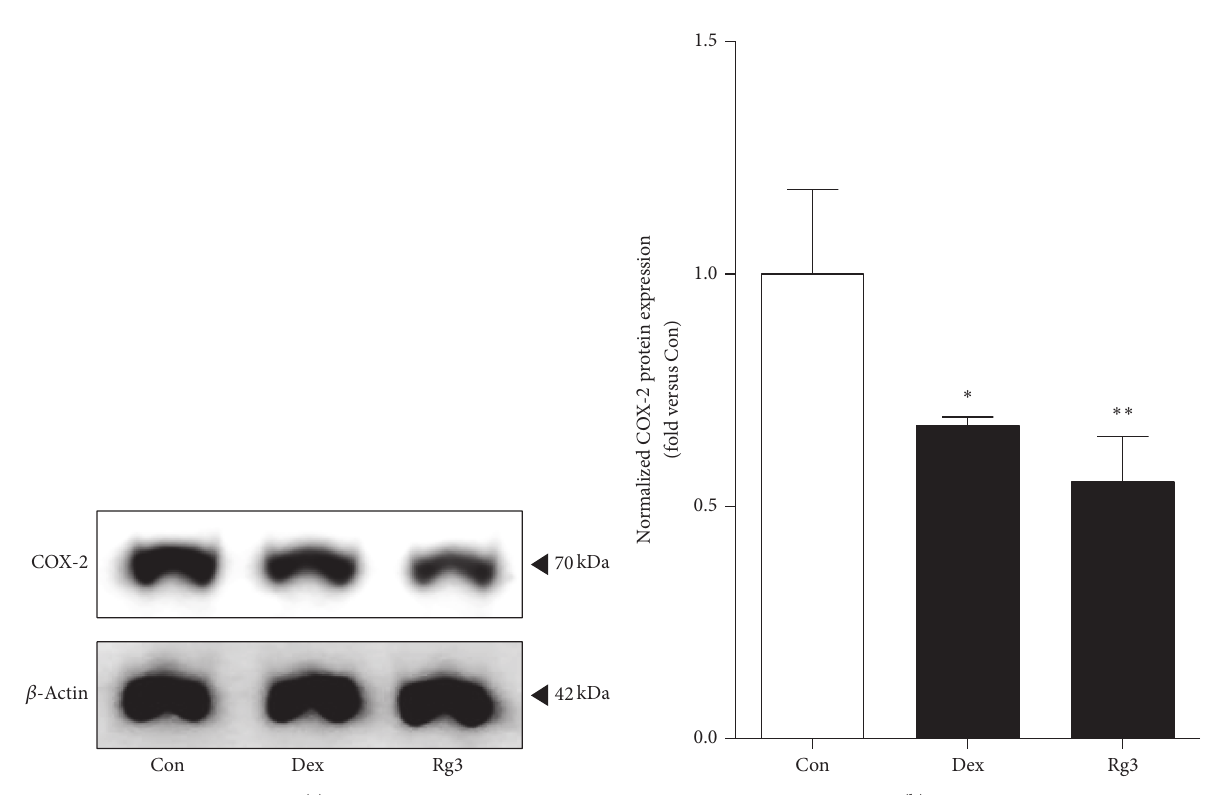
Figure5:EffectofRg3onCOX-2proteininhibitioninhumanasthmaticairwayepithelialtissues.(a)Humanasthmaticlungtissuewastreated with Dex for positive control or Rg3, and whole tissue lysates were prepared and then subjected to western blot analysis with anti-COX-2 antibodies. Anti- 𝛽 -actin antibody was used as an internal control. The blots were normalized by 𝛽 -actin expression levels and compared to the saline-treated tissue. (b) Normalized COX-2 expression was measured by Image J program and represented as bar charts. Statistical significance was determined by unpaired 𝑡 test (one-tail) compared to Con (only PBS-treated asthmatic lung tissue). Values are means ± SEM; ∗ 𝑃 < 0.05; ∗∗ 𝑃 <